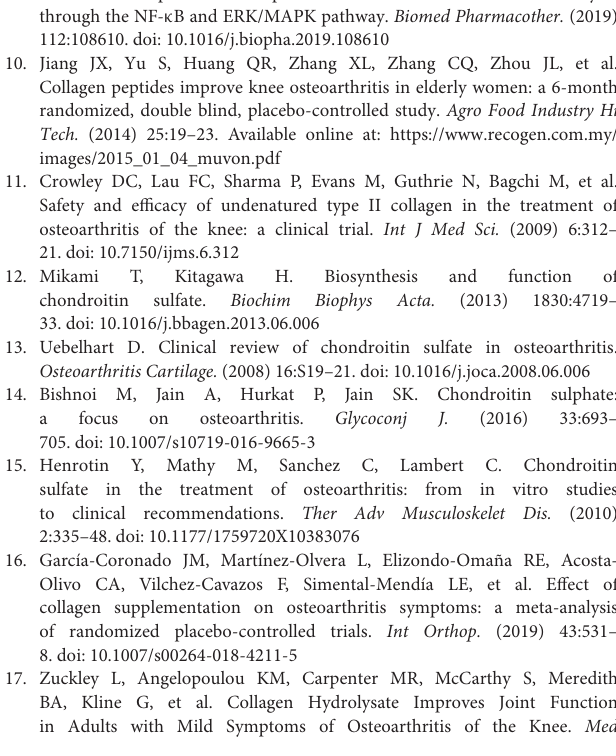
Supplementary Figure 1 | (A) Relative abundance of Proteobacteria . (B) Relative abundance of Bacteroidetes . The symbols indicate statistical significance: ns ( P > 0.05). Supplementary Figure 2 | Spearman’s r correlations between the inflammatory cytokines and the gut microbiota. (A) Family level. (B) Genus level. (C) Species level. Significant correlations were noted by ∗ P ≤ 0.05, ∗∗ P ≤